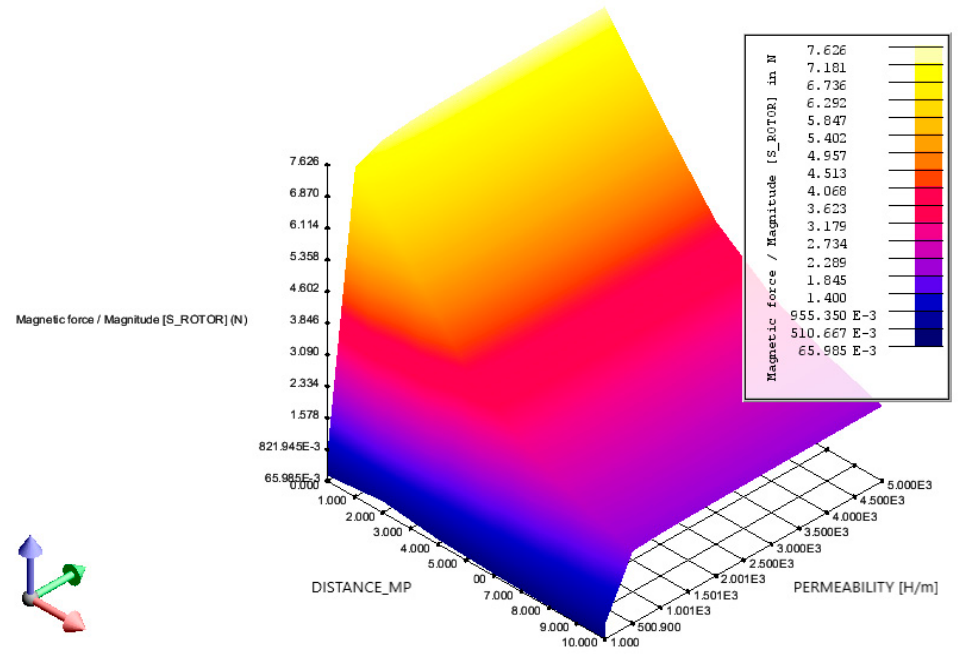
Figure 19. Variation of the magnetic force of attraction to the change in permeability gadolinium and the distance between permanent magnets—3D representation.